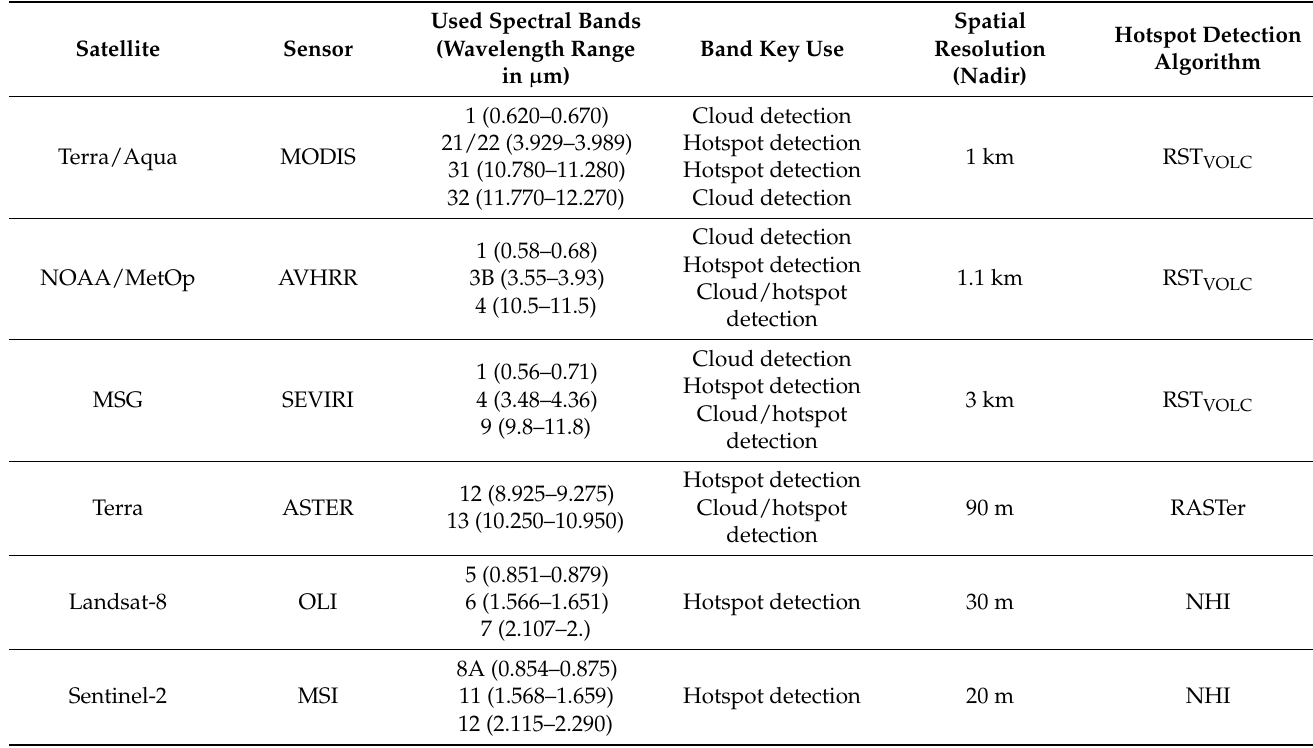
Table 1. Satellite data used in this work, key use of each exploited band, spatial resolution, hotspot detection algorithm.